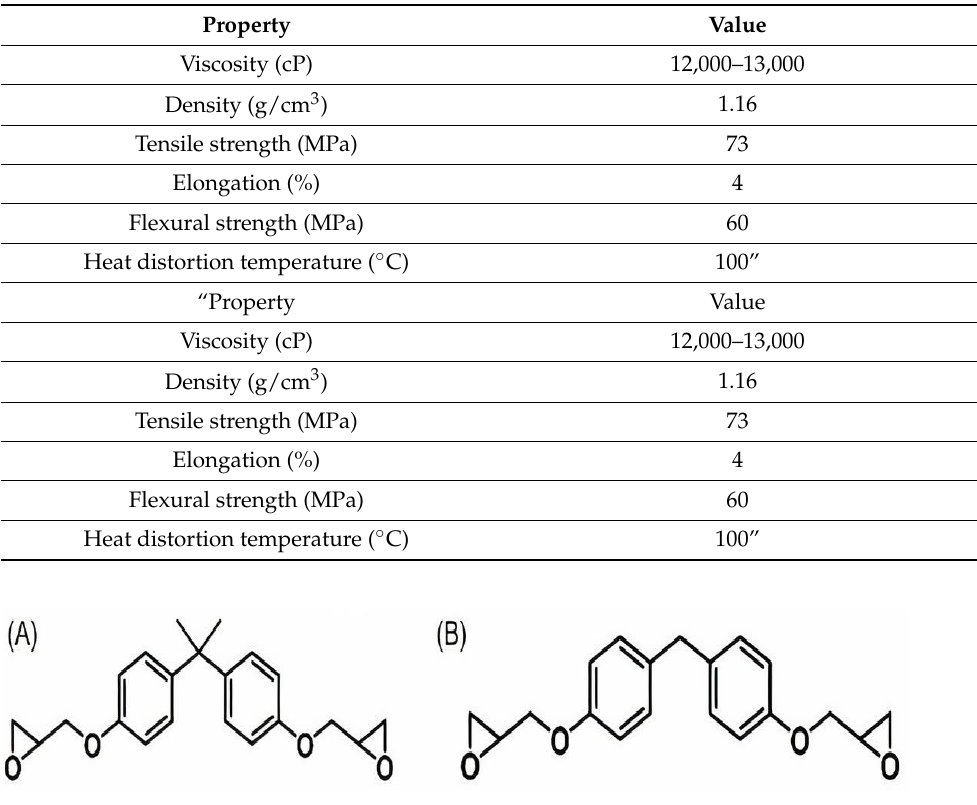
Figure 24. ( A ) Epon 828-bisphenol A ( B ) Epon 862-bisphenol F